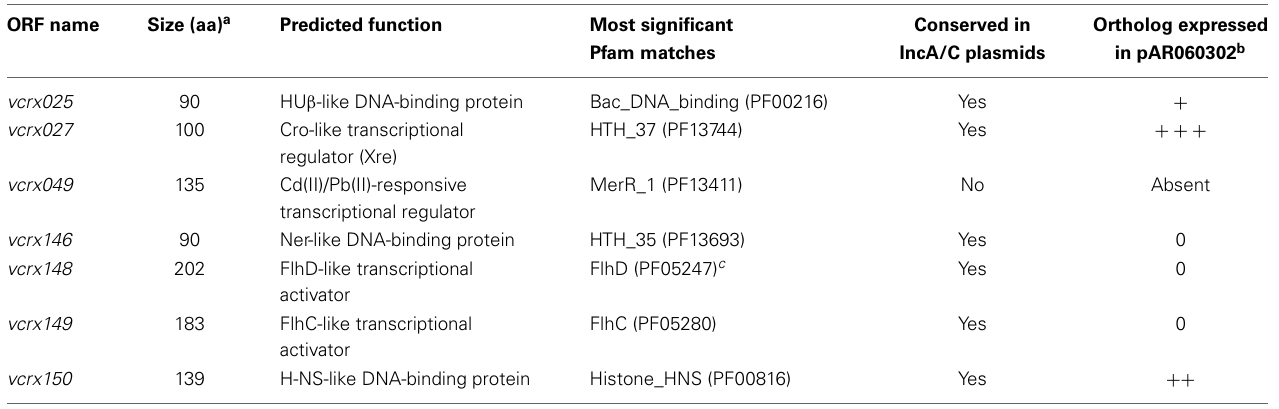
Table 4 | Open reading frames (ORFs) of pVCR94 (cid:2) X coding for putative transcriptional